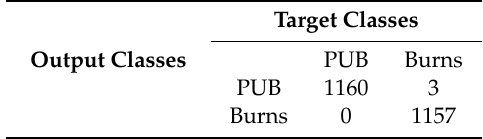
Table 2. SVM classification using ResNet101 features.